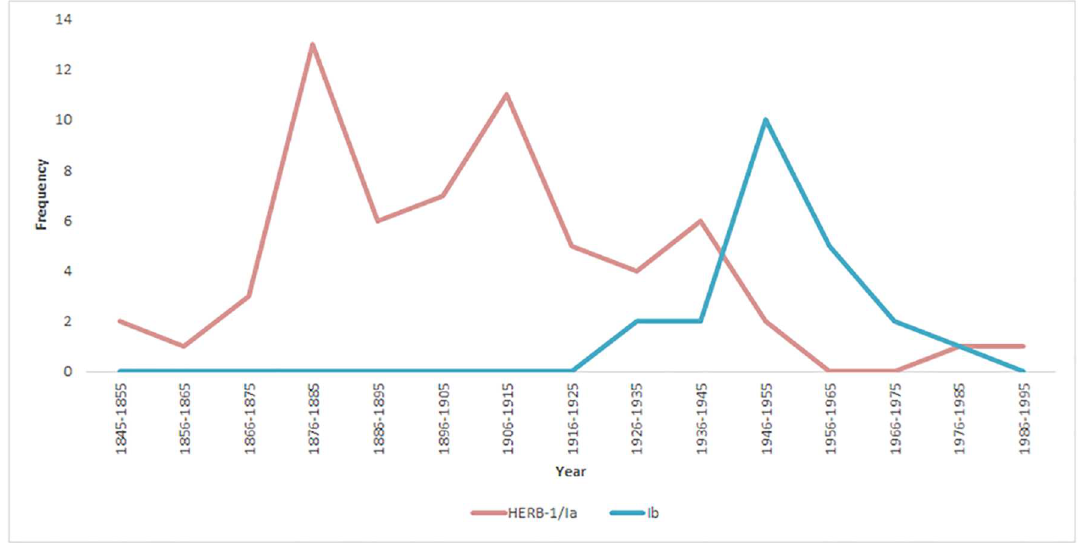
Fig 3. Number of HERB-1/Ia and Ib mitochondrial haplotypes (1845 to 1995) of Phytophthora infestans in herbaria collections. Mitochondrial haplotypes were identifiedfrom P . infestans in herbariumcollectionsshown in the S1